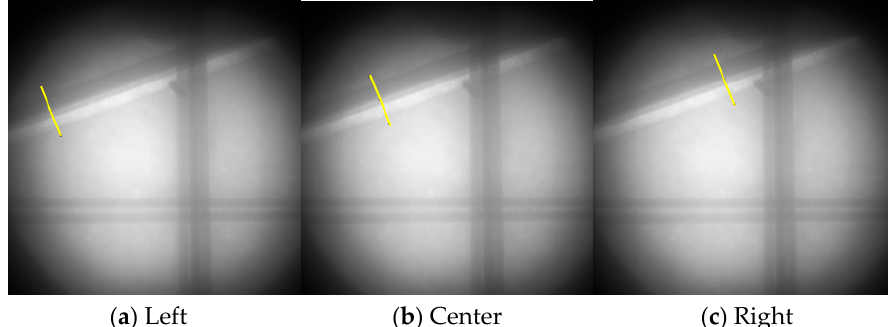
Figure 25. X-ray image of unfilled grout in a 200 mm thick T-shape PC girder bridge taken by the 950